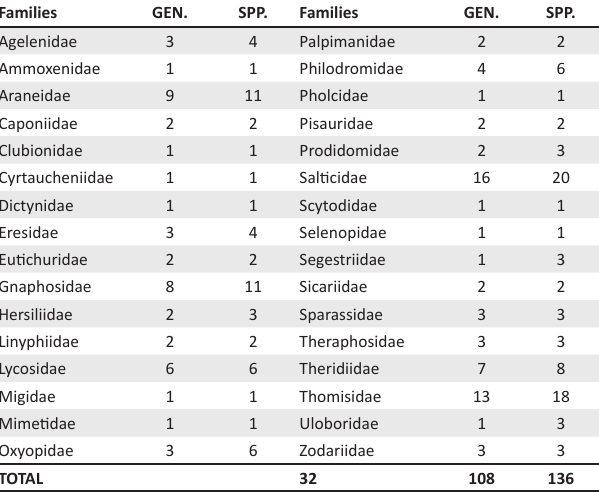
TABLE 4: Spider diversity of Tswalu Kalahari Reserve, with total number of families, genera and species sampled. Families GEN. SPP. Families GEN.